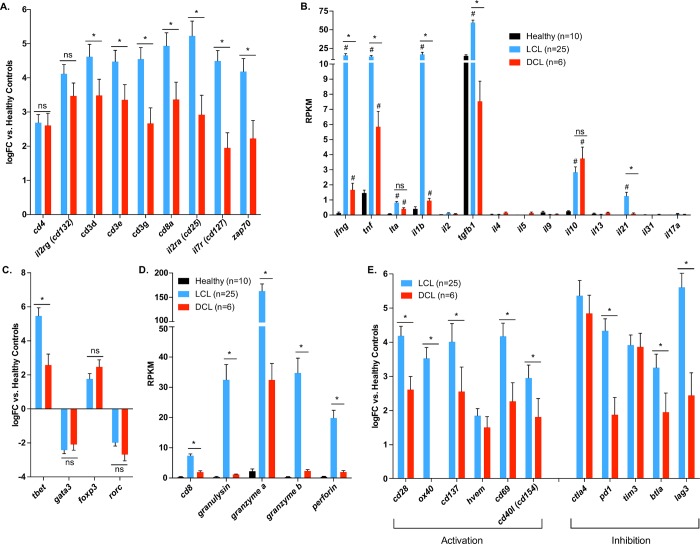
Altered cytotoxic T cell responses in DCL lesions.(A) Bars represent the log2 fold-change of T cell markers in LCL (blue) and DCL (red) patients (mean plus sem, p < 0.05) relative to healthy patients. Differences between LCL and DCL are indicated (*adjusted p-value < 0.05, ns = not significant). (B) Bars show average RPKM values (plus SEM) for healthy (black), LCL (blue), and DCL (red) for cytokines involved in TH1 (ifng, tnf, lta, il1b, il2), TH2 (tgfb1, il4, il5, il9, il10, il13, il21, il31), and TH17 (il17a) responses. Significant differences versus healthy (#,adjusted p-value < 0.05) and between LCL and DCL (*adjusted p-value < 0.05) are indicated. (C) Bars represent the log2 fold-change of T cell transcription factors in LCL (blue) and DCL (red) patients (mean plus sem, p < 0.05) relative to healthy patients. Differences between LCL and DCL are indicated (*adjusted p-value < 0.05, ns = not significant). (D) Bars show mean RPKM values (plus SEM) for healthy (black), LCL (blue), and DCL (red) for CD8 and cytotoxic T lymphocyte effector molecules. Significant differences between LCL and DCL are indicated (*adjusted p-value < 0.05). (E) Bars represent the log2 fold-change of T cell activation and inhibition markers in LCL (blue) and DCL (red) patients (mean plus sem, p < 0.05) relative to healthy patients. Differences between LCL and DCL are indicated (*adjusted p-value < 0.05, ns = not significant).